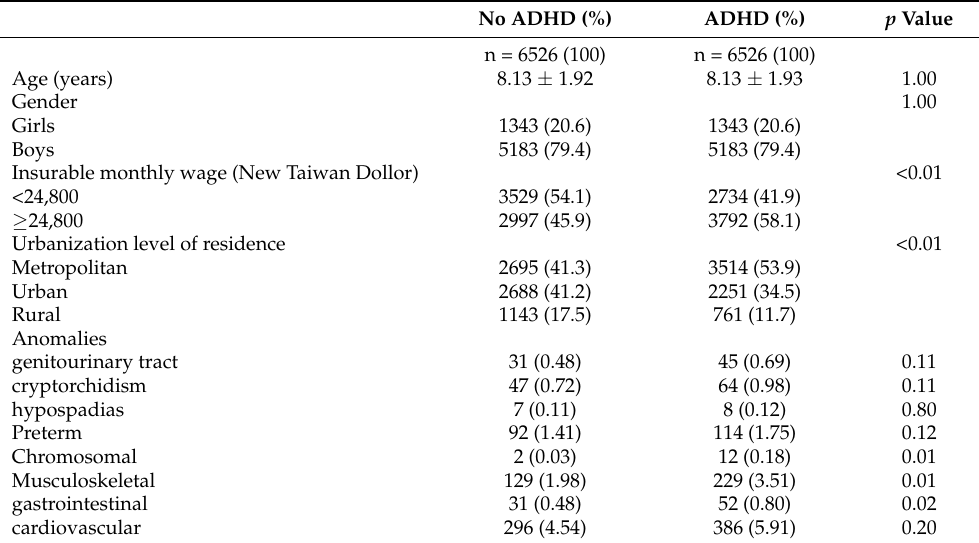
Table 4. The baseline characteristics in school-age children with ADHD versus no ADHD, in the nationwide, population-based